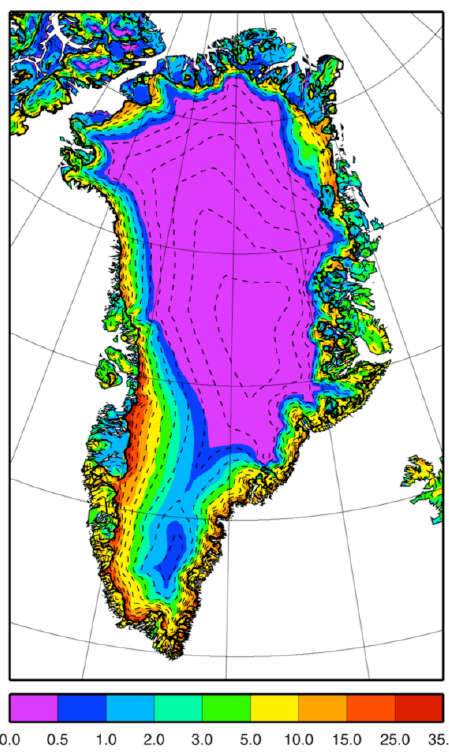
Fig. 16. Annual mean melt energy M [Wm − 2